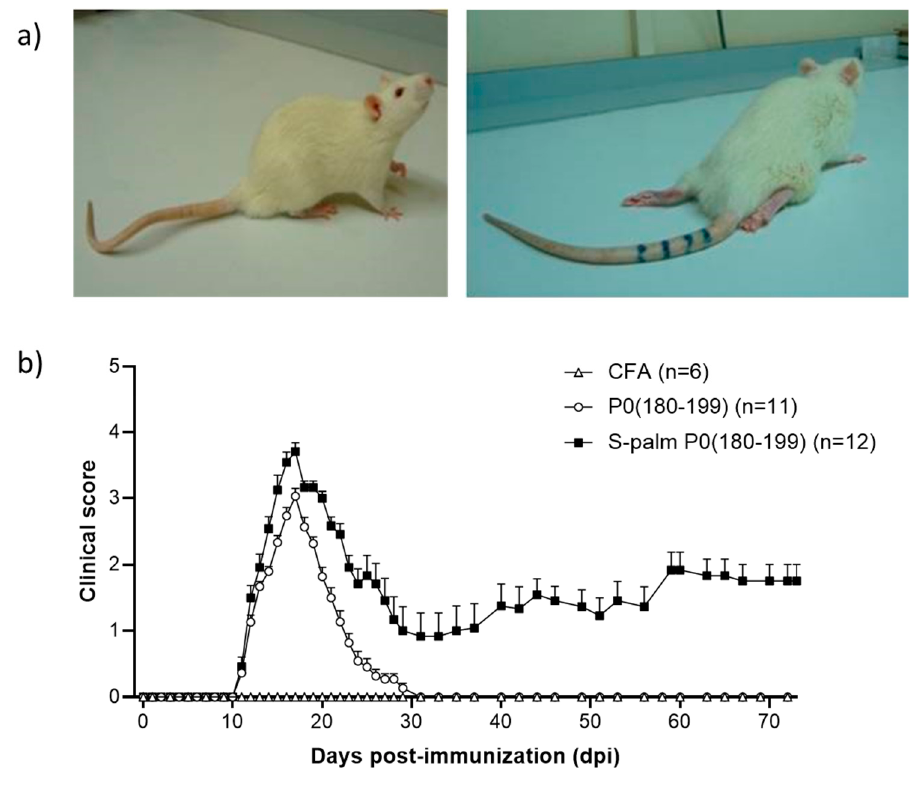
Figure 3. Clinical scores in the c-EAN rat model mimicking CIDP. ( a ) Visualization of clinical scores from male Lewis rat aged nine weeks: (Left) Rat immunized with CFA and not developing clinical sign (clinical score of 0), (Right) Rat immunized with S-palm P0(180–199) peptide plus CFA and developing CIDP (clinical score of 3) (From [86]). ( b ) Clinical course of EAN and c-EAN in Lewis rats immunized with P0(180–199)/CFA ( ○ ), S-palm P0(180–199)/CFA ( ■ ) or CFA as control ( ∆ ). Mean values and SEM are indicated (From [81]). Abbreviations: c-EAN, chronic experimental autoimmune neuritis; CIDP, chronic inflammatory demyelinating polyneuropathy; CFA, complete Freund’s adjuvant. n, number of rats included in the study.